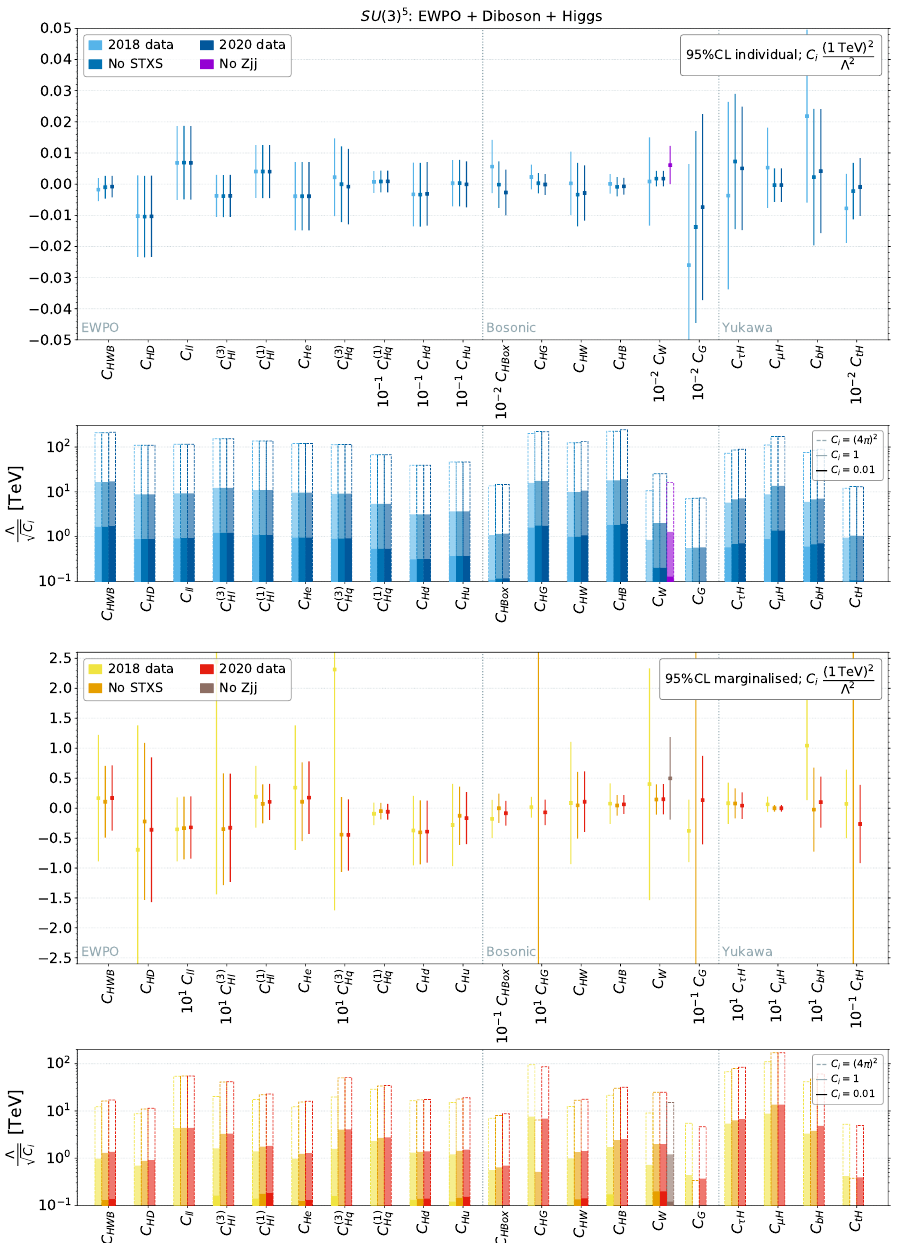
Figure 3 . Constraints on the indicated individual and marginalised operator coefficients C i (1 TeV) 2 / Λ 2 (top and third panels) and the corresponding scales Λ for the indicated values of the C at the 95% confidence level (second and bottom panels), from a combined linear fit to the i Higgs, diboson and electroweak precision observables. In the top two panels, the bars show the 95% CL ranges from the LHC Run 1 and early Run 2 data (light blue), current data without using the STXS measurements (intermediate blue), and current data including STXS using either the on-shell vector boson approximation or the full 1 → 4 matrix elements for the 4-fermion Higgs decay modes taken from ref. [173] (dark blue). In the bottom two panels, the corresponding marginalised results are indicated by yellow, orange and red bars, respectively. We also show in purple in the individual case (grey in the marginalised case) the effect of dropping the ATLAS Z + jets